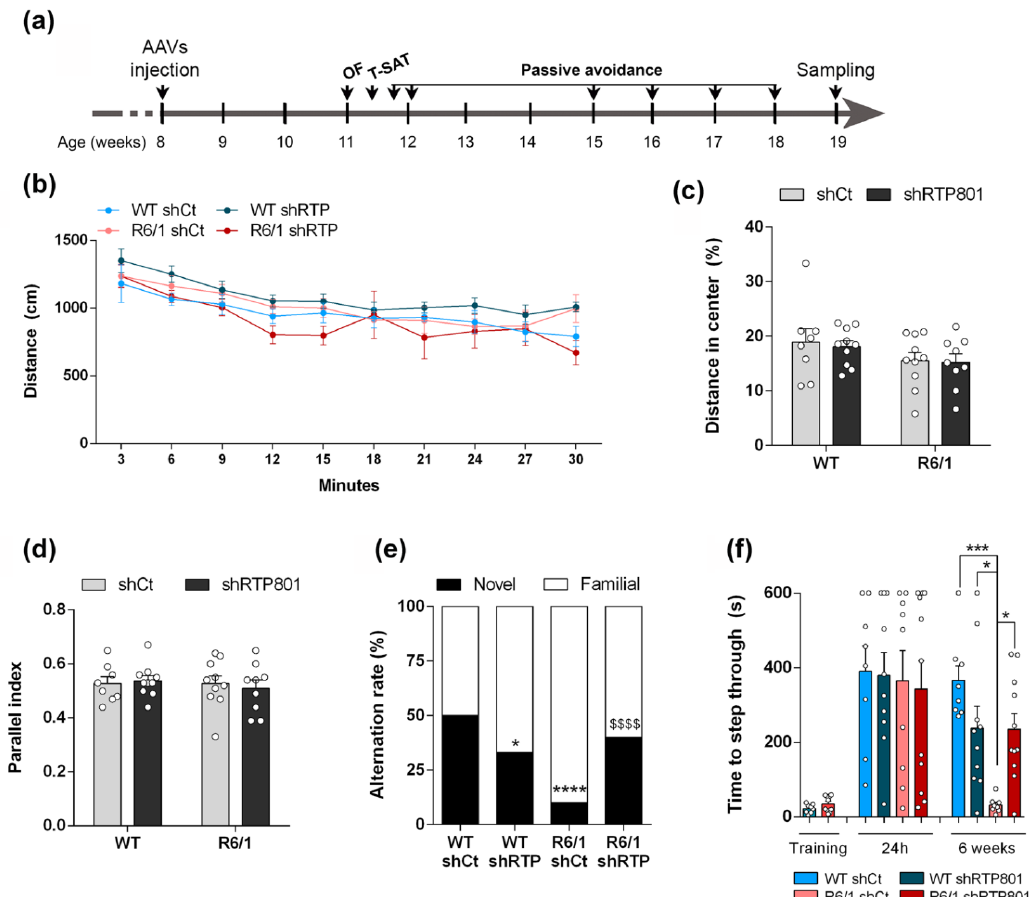
Four weeks after AAVs injection, when cognitive symptoms had already appeared in this mouse model [42,43], we performed a broad behavioral characterization as depicted in Figure 2a. First, all mice were subjected to the open field test (OF) to discard a shRTP801 effect over general locomotion, since hippocampal principal neurons can regulate motor behavior [44]. RTP801 downregulation did not induce significant changes in travelled distance, thigmotaxis, or parallel index (Figure 2b–d). No differences were found between genotypes, as expected [45] (Two-way ANOVA group effect for travelled distance F (3,32) = 1.767, p = 0.1732; genotype effect for percentage of distance in the center of the arena F (1,33) = 3.517, p = 0.0696; and genotype effect for parallel index F (1,33) = 3.712, p = 0.0627).